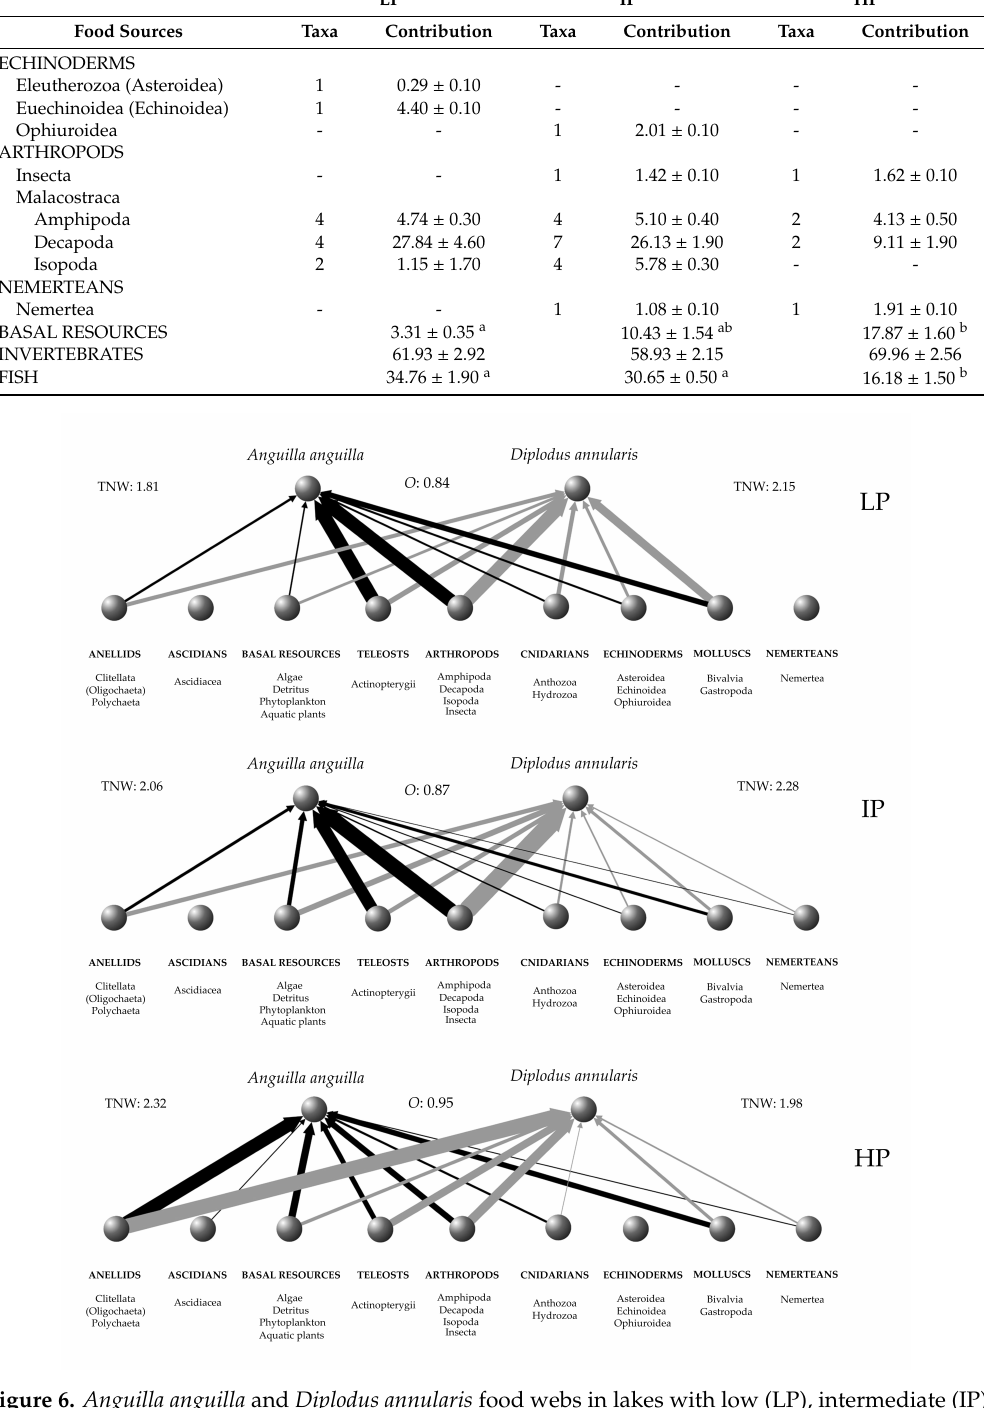
Figure 6. Anguilla anguilla and Diplodus annularis food webs in lakes with low (LP), intermediate (IP) and high (HP) eutrophication. Each node at the base of the food web represents a food source (in terms of class and respective families). Arrows point from each food item to its consumer: Anguilla anguilla (black arrows) and Diplodus annularis (grey arrows). The arrows’ thickness is proportional to the trophic interaction strength. TNW indicates trophic niche width. O indicates the niche overlap between D. annularis and A. anguilla . For details of metrics, please refer to the results